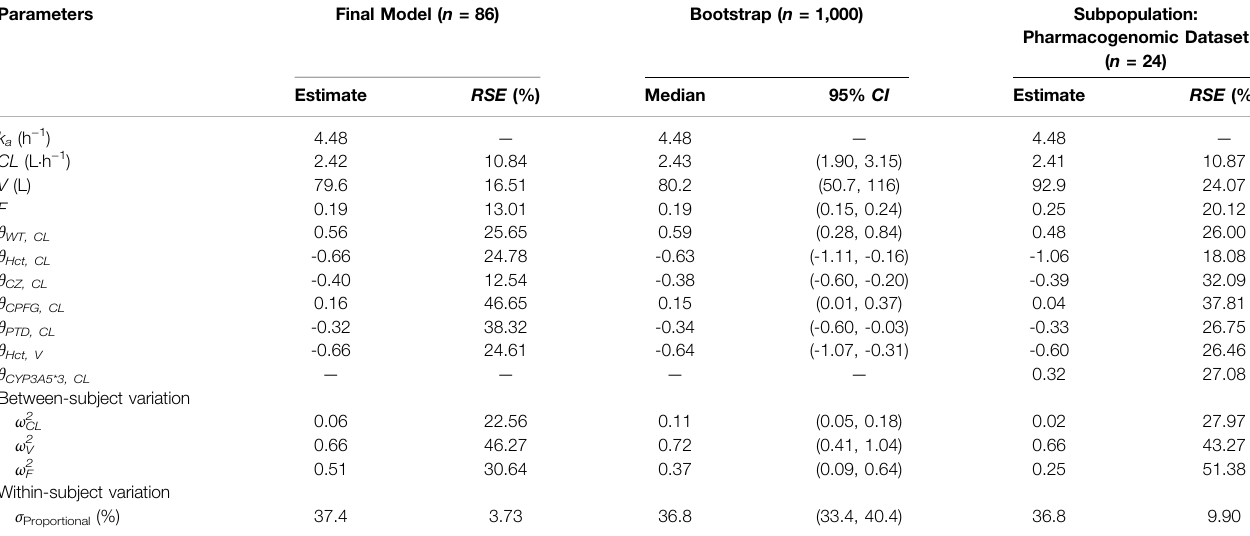
TABLE 3 | Population pharmacokinetic parameters of tacrolimus and bootstrap validation.